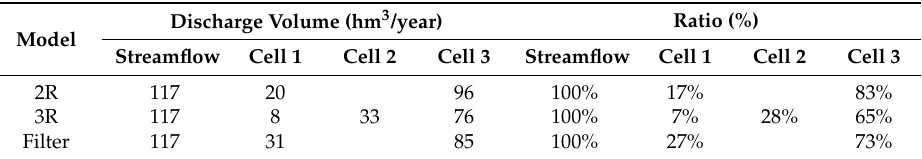
Table 6. Parameters of the models of three deposits.